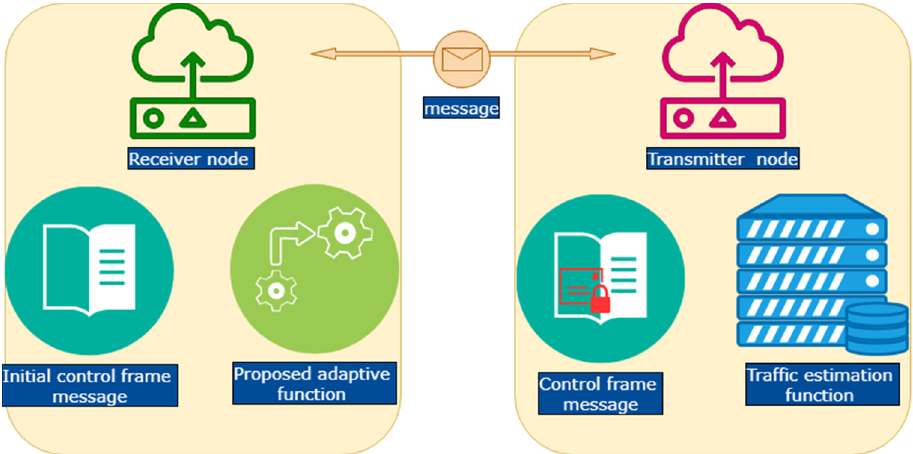
Figure 2. The main components of the proposed Adaptive Wake ‐ Up Preamble Sampling MAC Protocol (AWR ‐ PS ‐ MAC).